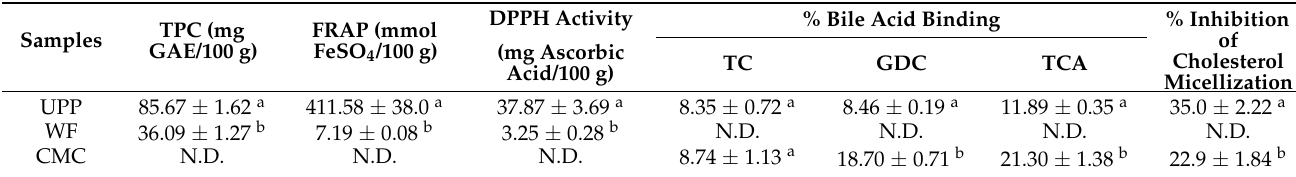
Table 2. Total phenolic content, antioxidant activity, bile acid binding and the inhibition of cholesterol micellization of unripe papaya